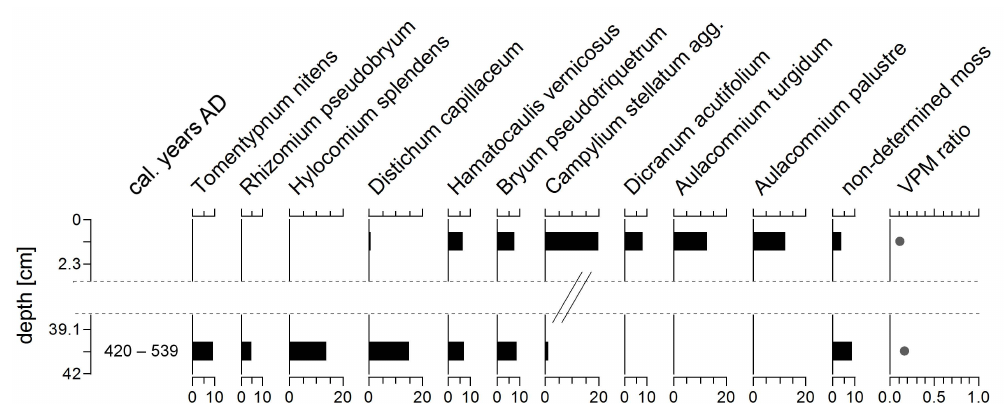
Fig. A3. Moss spectrum for Section A. Only the surface and bottom samples from this section were analysed.